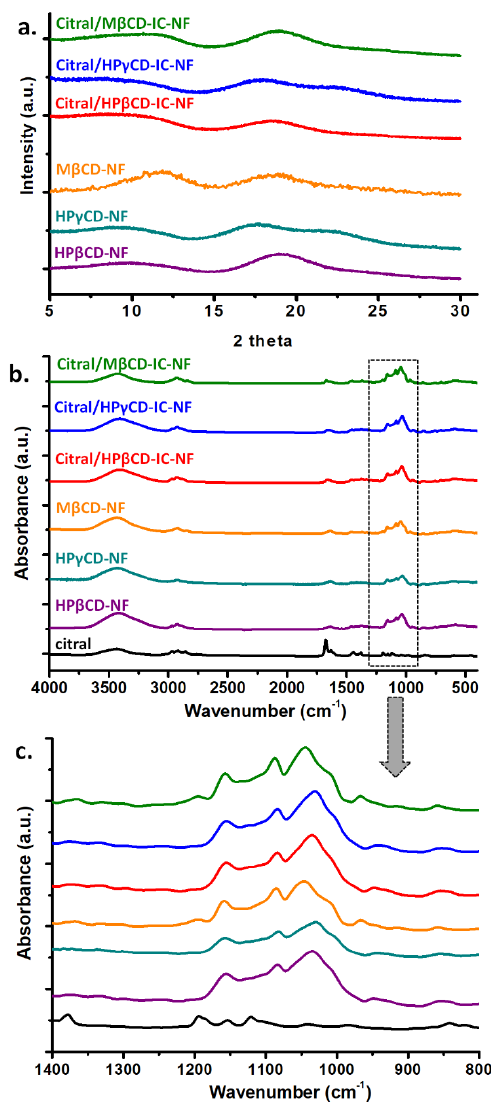
Figure 7. ( a ) X-ray diffraction (XRD) patterns of HPβCD-NF, HPγCD-NF, MβCD-NF, citral/HPβCD-IC-NF, citral/HPγCD-IC-NF, and citral/MβCD-IC-NF; ( b ) full and ( c ) narrow range Fourier-transform infrared (FTIR) spectra of citral, HPβCD-NF, HPγCD-NF, MβCD-NF, citral/HPβCD-IC-NF, citral/HPγCD-IC-NF, and citral/MβCD-IC-NF. FTIR analyses of citral, HPβCD-NF, HPγCD-NF, MβCD-NF, citral/HPβCD-IC-NF, citral/HPγCD-IC-NF, and citral/MβCD-IC-NF are presented in Figure 7b,c. CDs exhibited characteristic absorption peaks at around 1030 cm −1 (coupled C–C stretching vibration), 1080 cm −1 (coupled stretching C–O vibration), 1157 cm −1 (antisymmetric stretching vibration of C–O–C